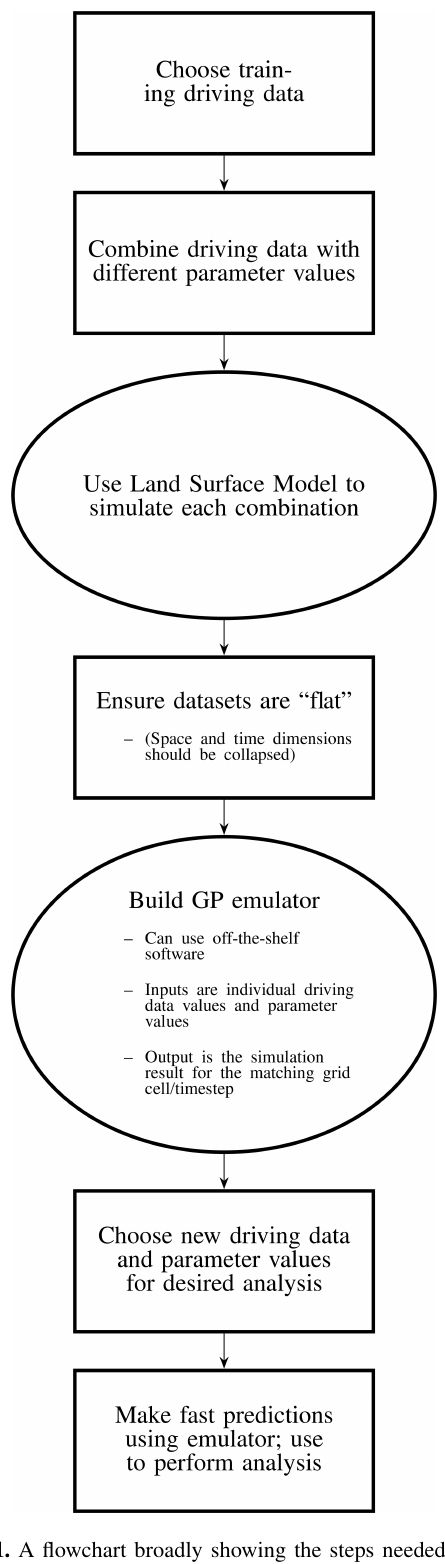
Figure 1. A flowchart broadly showing the steps needed to build and use a land surface emulator under our